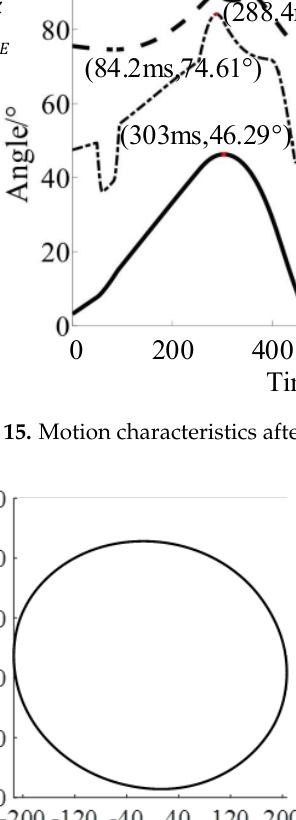
Figure 16. Cam theory curve after optimization.